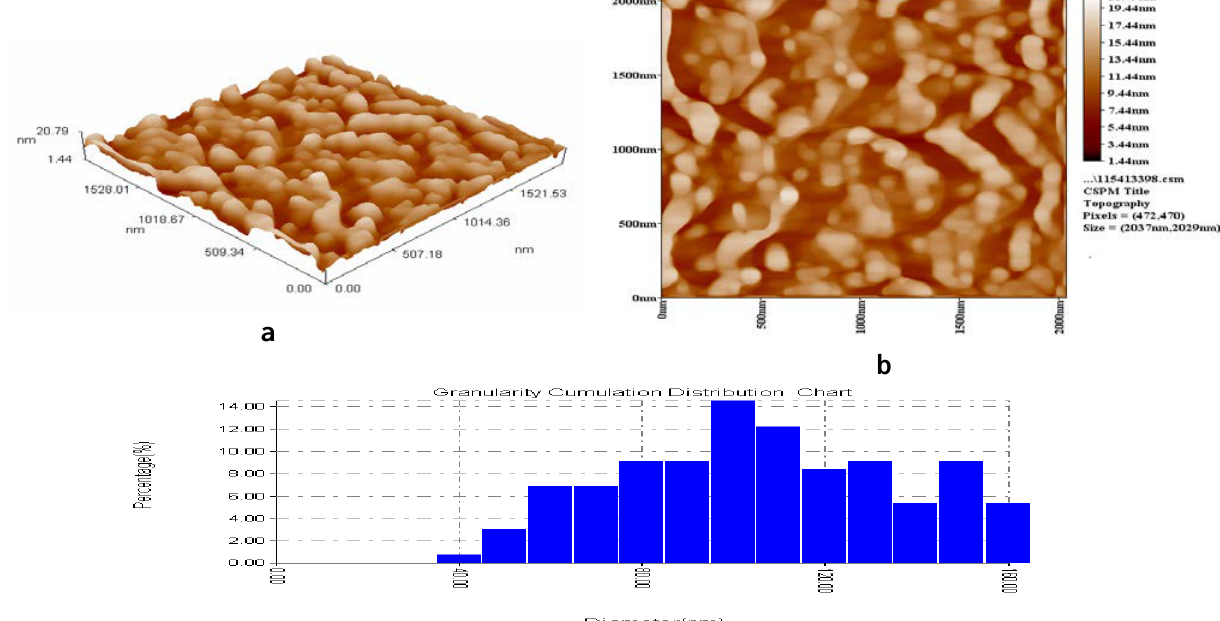
Fig.6: AFM photographs of pure polyaniline thin film surface a-3D image b-2 D image and c-size value